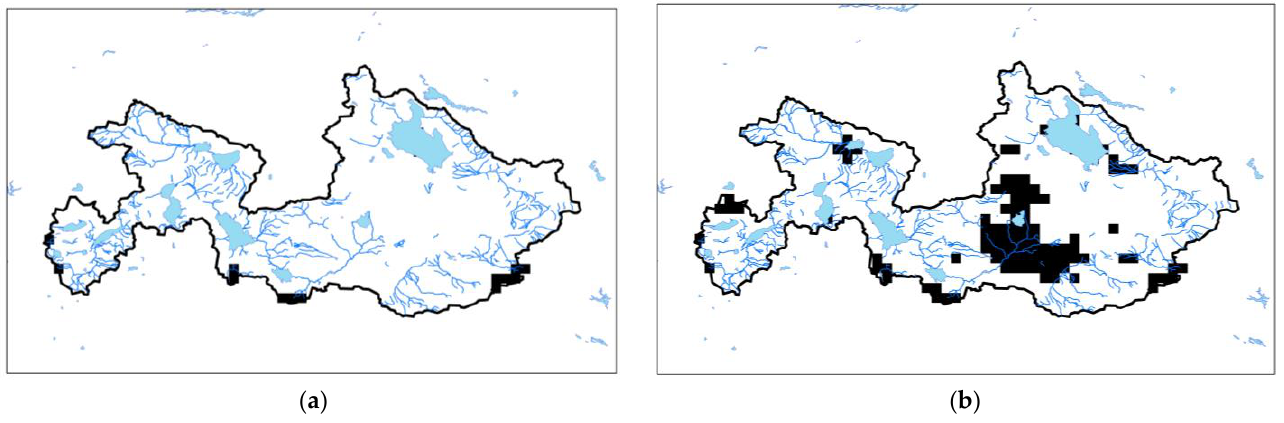
Figure 5. Runoff trend in the Central Anatolia Ecoregion. Black: no trend, white: decreasing trend. ( a ) Runoff trend in May; ( b ) Runoff trend in August.